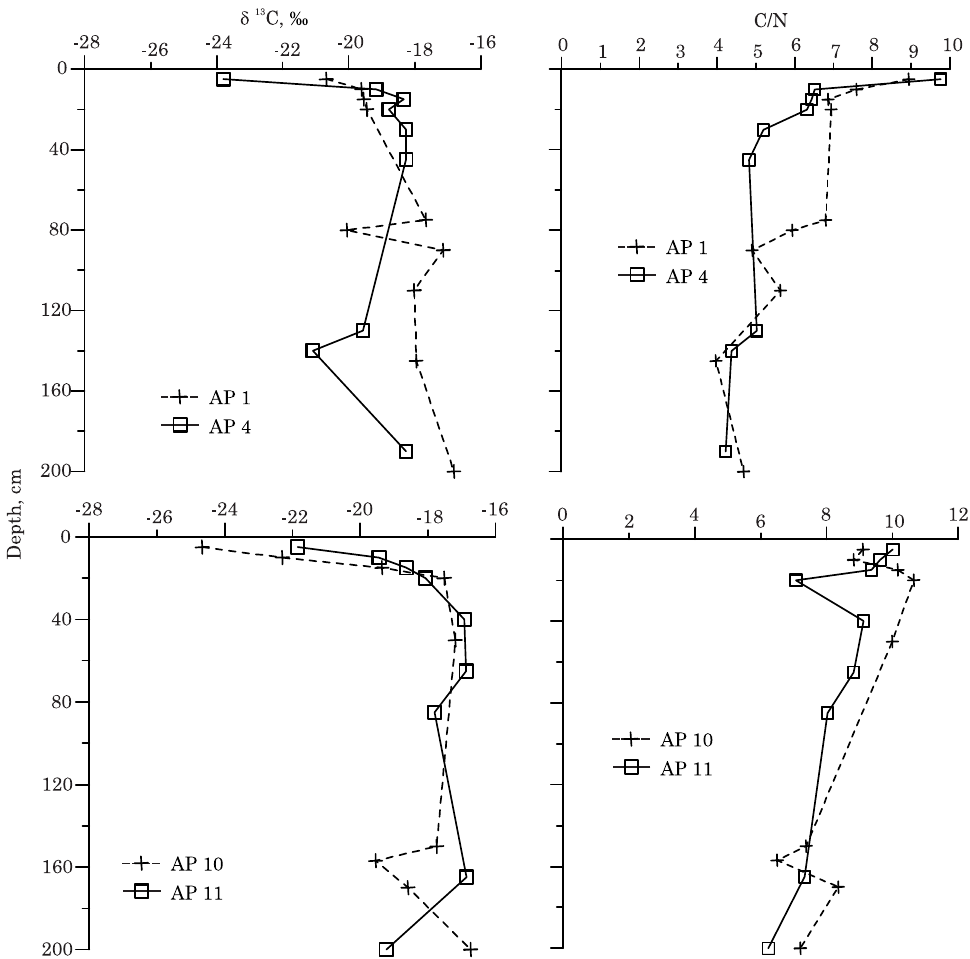
Figure 5. δδ δδ δ 13 C and C/N ratio of horizons and layers in AP1, AP4, AP10 and